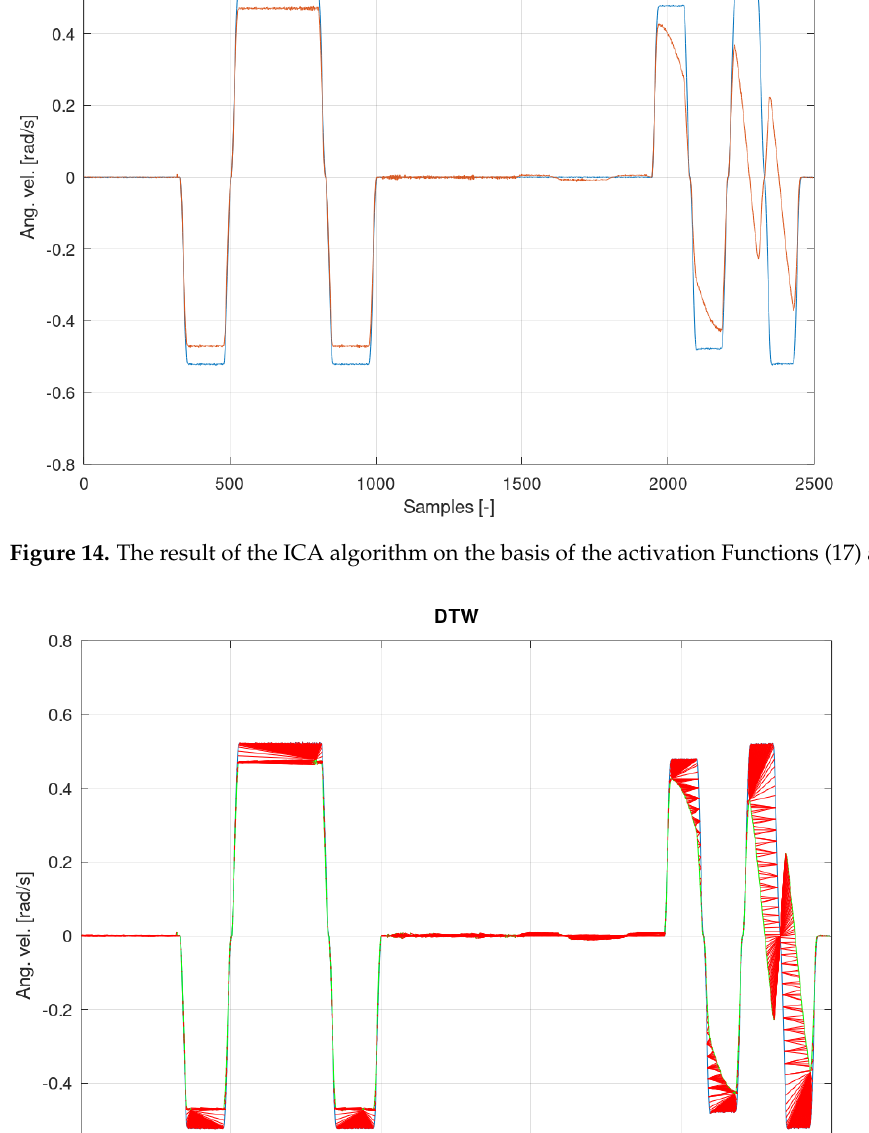
Figure 13. Analysis of the error from Figure 12 with the DTW algorithm.